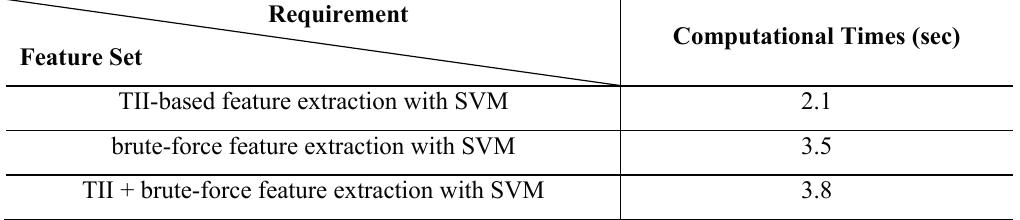
Table 14. The computational time with/without brute-force feature set on the ESS